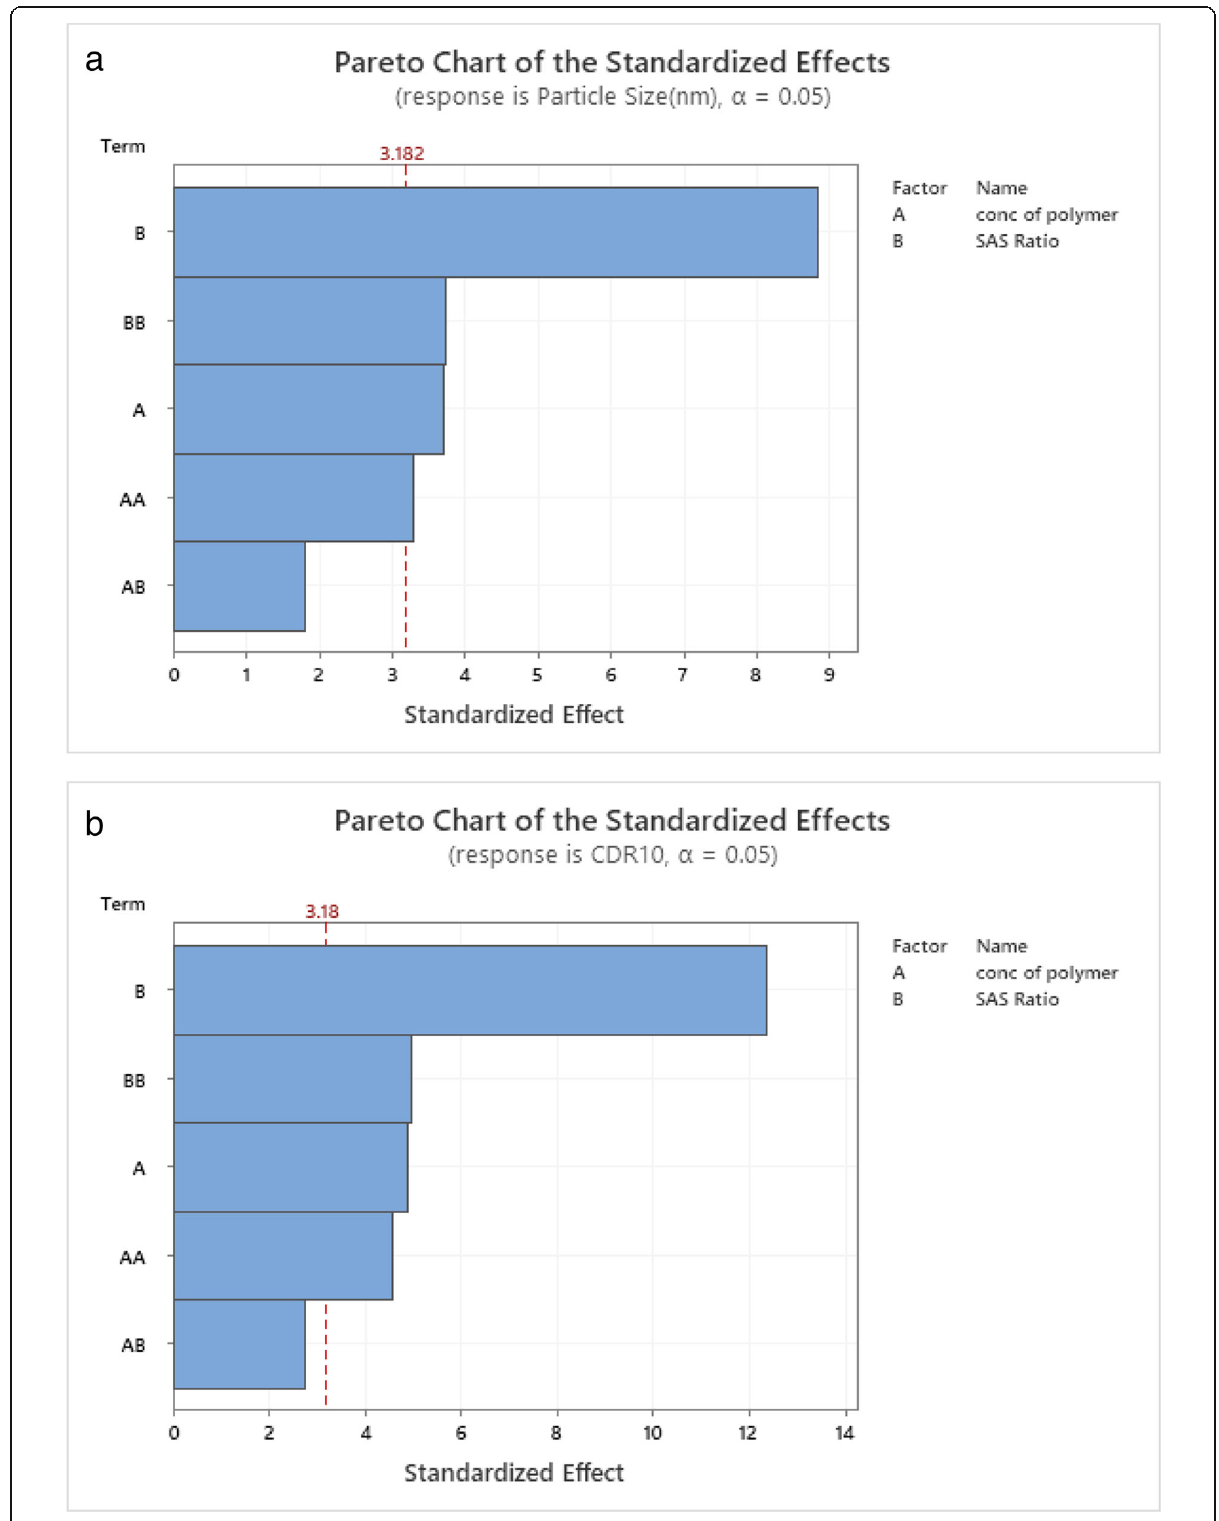
Fig. 3 Pareto chart of the standardized effects on a particle size and b